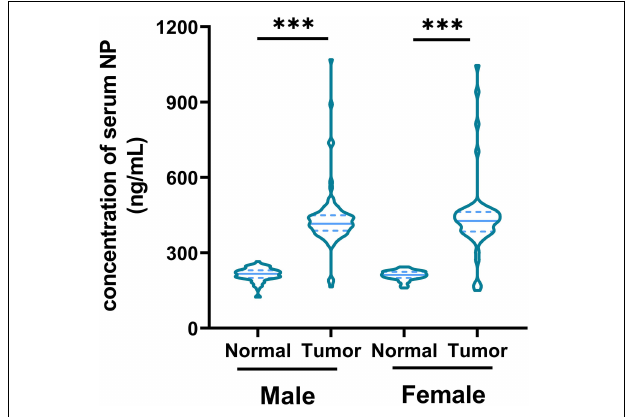
FIGURE 1 | Concentration of nonylphenol (NP) in serum from healthy patients ( n = 143) and patients with colorectal cancer (CRC; n = 143). ∗∗∗ p < 0.001.